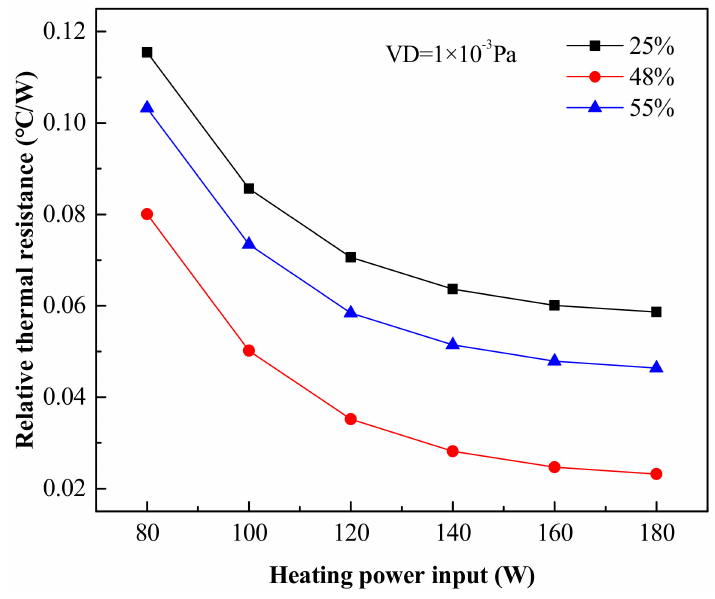
Figure 14. The relative thermal resistance on Z-axis of PGHP changing with heating power input under different fluid filling